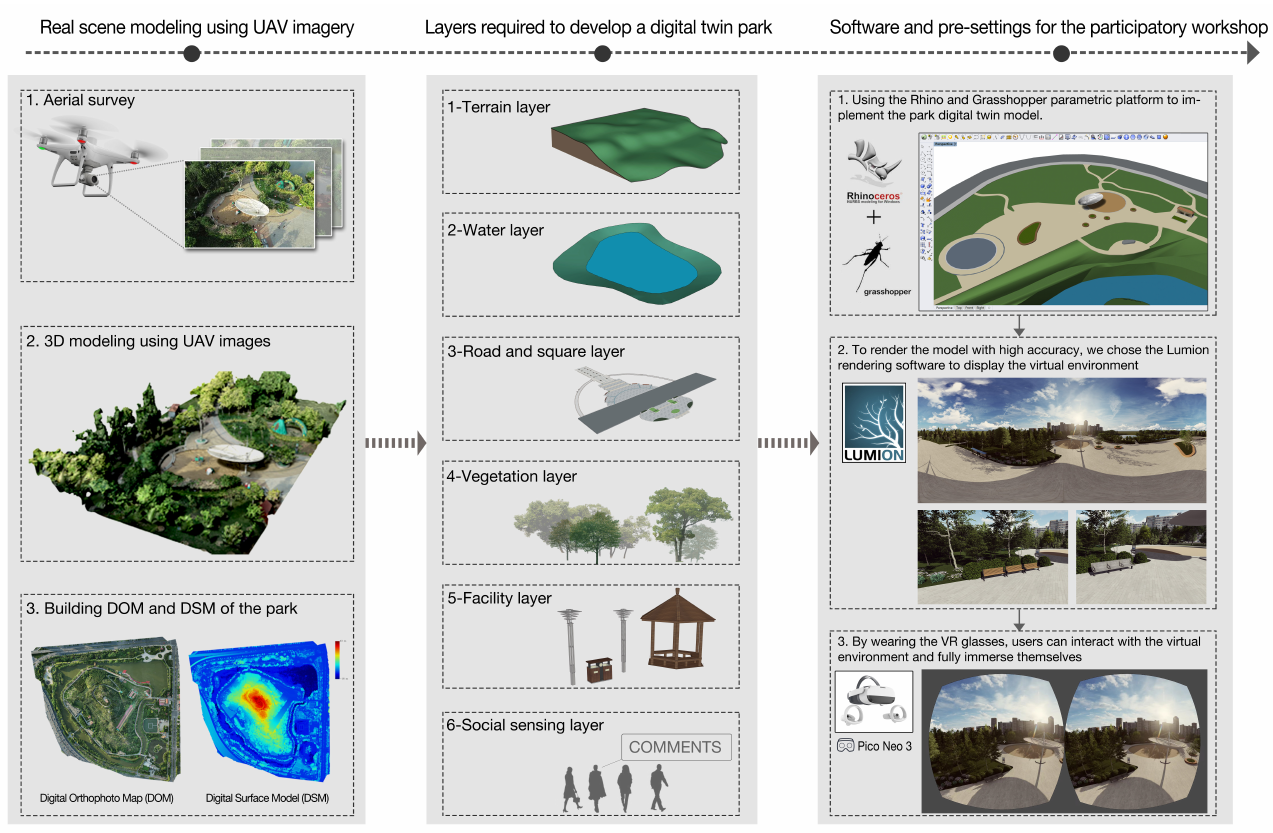
Figure 2. Digital twin system design of Nancuiping